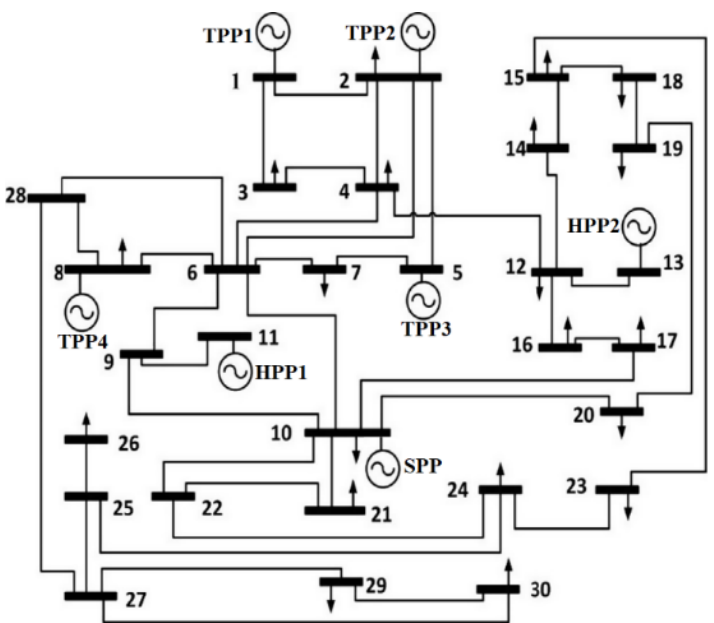
Figure 5. Single-line diagram of the modified IEEE 30 bus system.